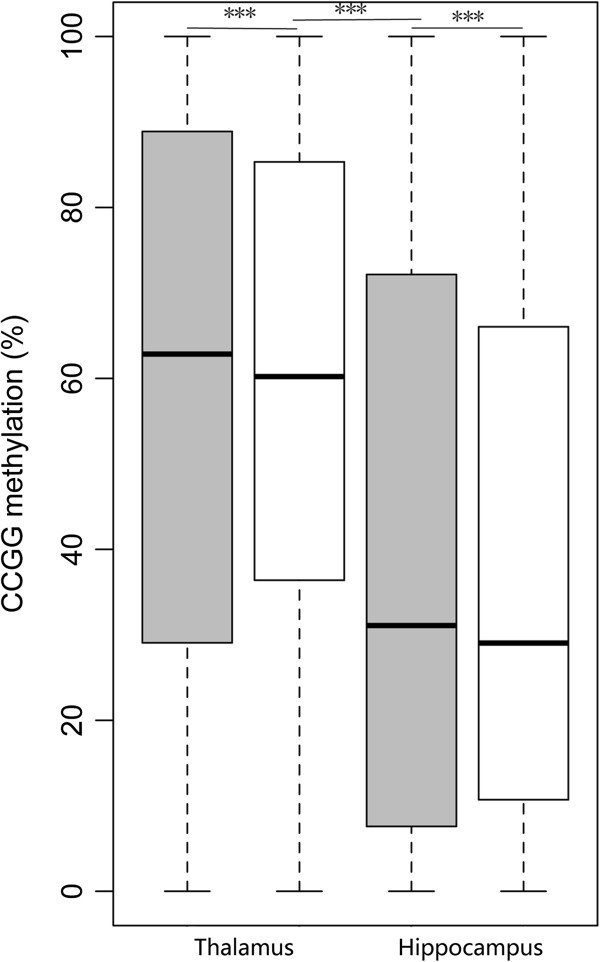
The overall methylation levels of all CCGG sites in the thalamus and hippocampus (control group in gray and famine group in white). The total methylation level at CCGG sites of the hippocampus was lower than that of the thalamus. ***P < 0.001 (control group and famine group in the thalamus and hippocampus, control group in the thalamus and hippocampus, famine group in the thalamus and hippocampus, Student’s t-test).